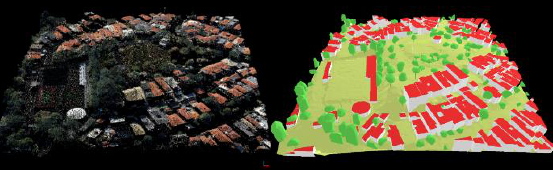
Figure 4. 3D representation of the input point cloud [left] and